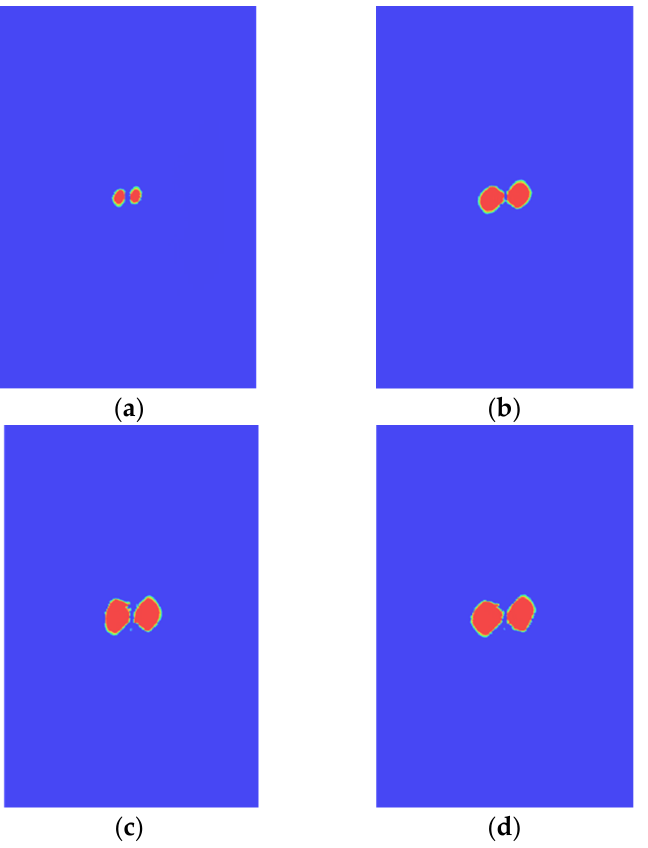
Figure 14. Delamination under different impact energy conditions. ( a ) Impact energy 10 J. ( b ) Impact